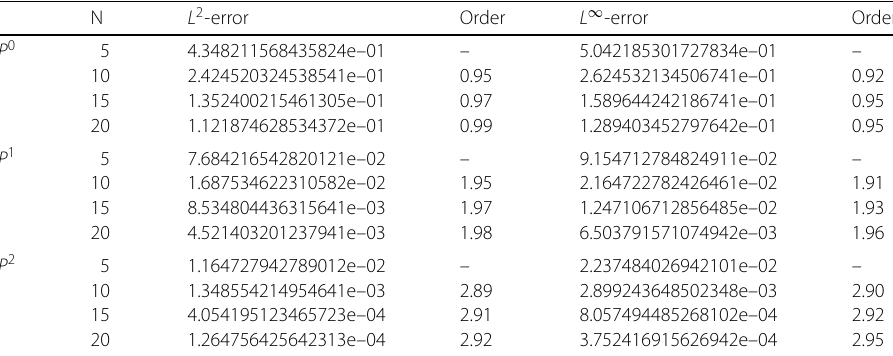
Table 2 Numerical accuracy of scheme (3.5) with M = 1000, α = 0.7